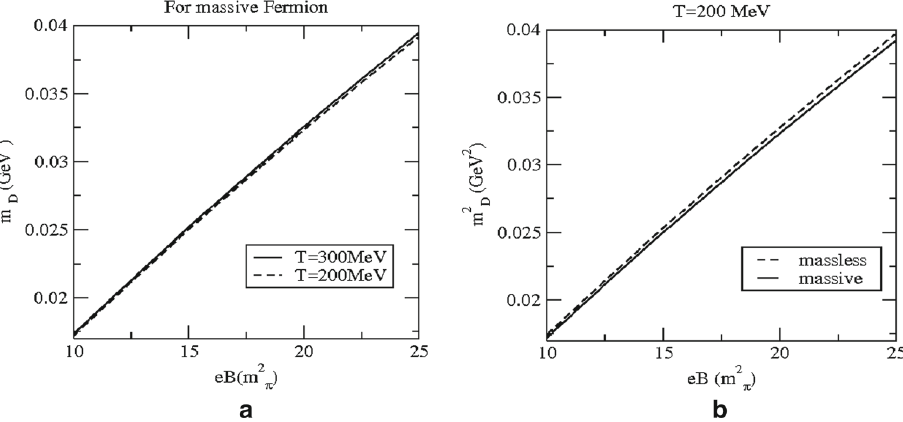
Fig. 1 Left panel: Separation is seen only between low and high T at high eB. Right panel: High eB can distinguish massless and massive fermions